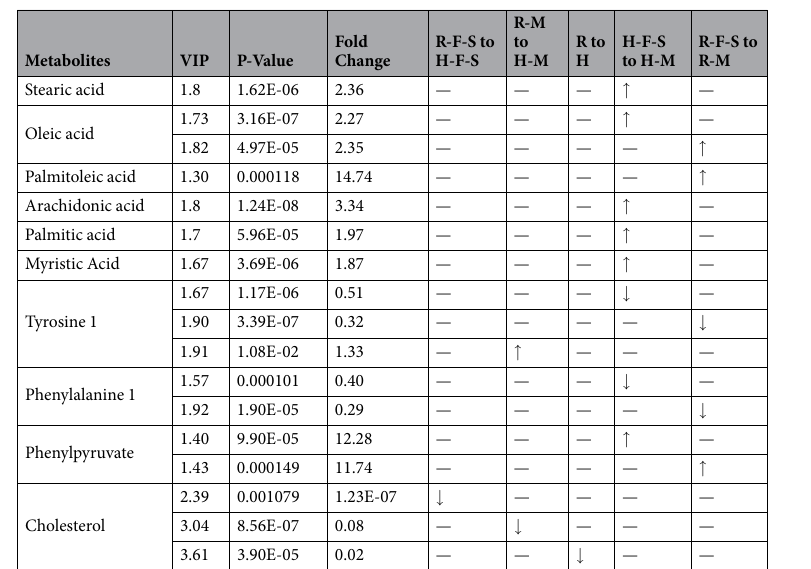
Table 2. The change of important different metabolites among different groups. ↑ , increase; ↓ , decrease; —, no change. VIP: the value of variable importance in the projection; P-VALUE: P-value of Student’s t-test; FOLD CHANGE: the ratio of the contents of experimental substances in two